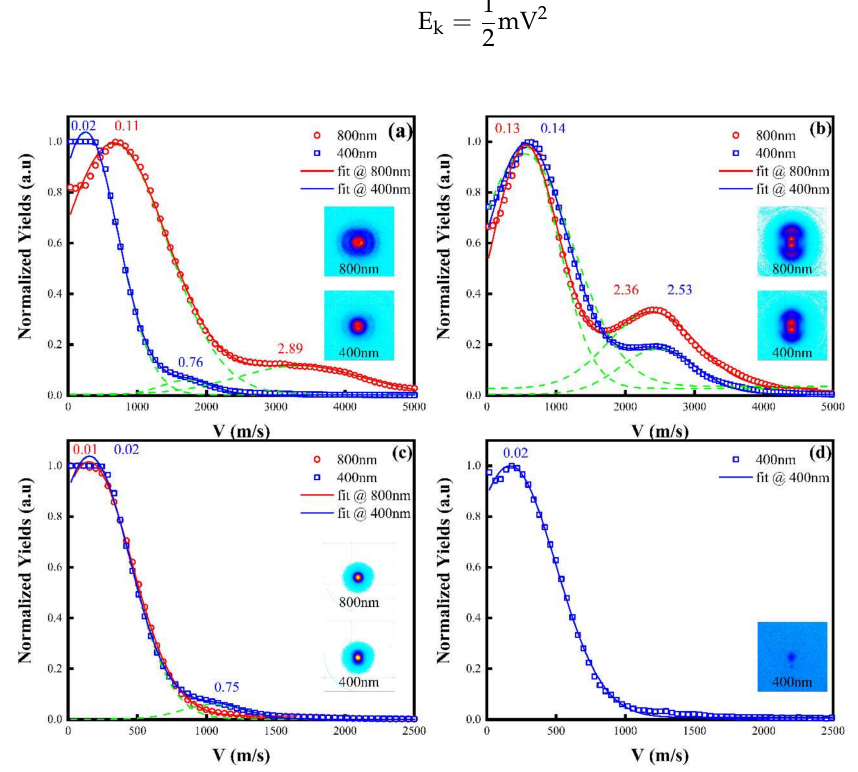
Figure 2. The sliced images, corresponding velocity distributions and peak values (eV) of the fragment ions ( a ) CF 2+ (50), ( b )Br + (80), ( c )CF 2 Br + (130) and ( d )Br 2+ (160) in 800 and 400 nm laser fields. The open scatters ( ) and ( (cid:3) ) are the experimental data in 800 nm(red) and 400 nm (blue) (cid:35) laser fields, the green dash lines (——) represent the envelope of each fitting Gaussian function and the red and blue solid lines (——) are the final fitting curves of the velocity